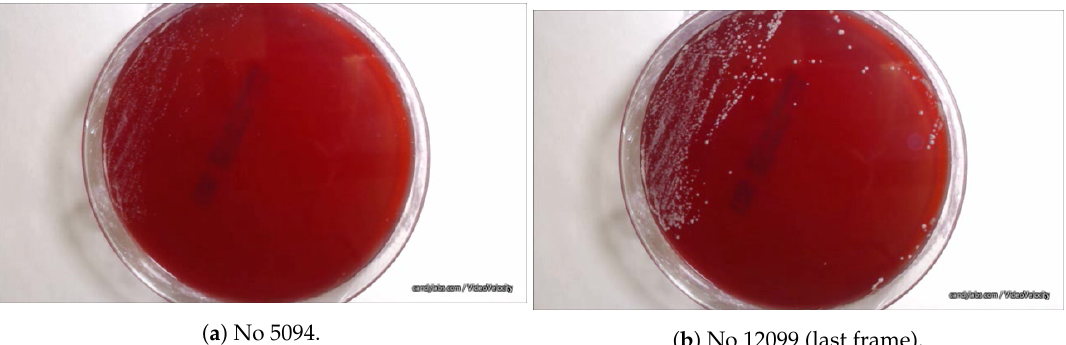
Figure 2. Two petri dish 1 frames in different microbial evolution